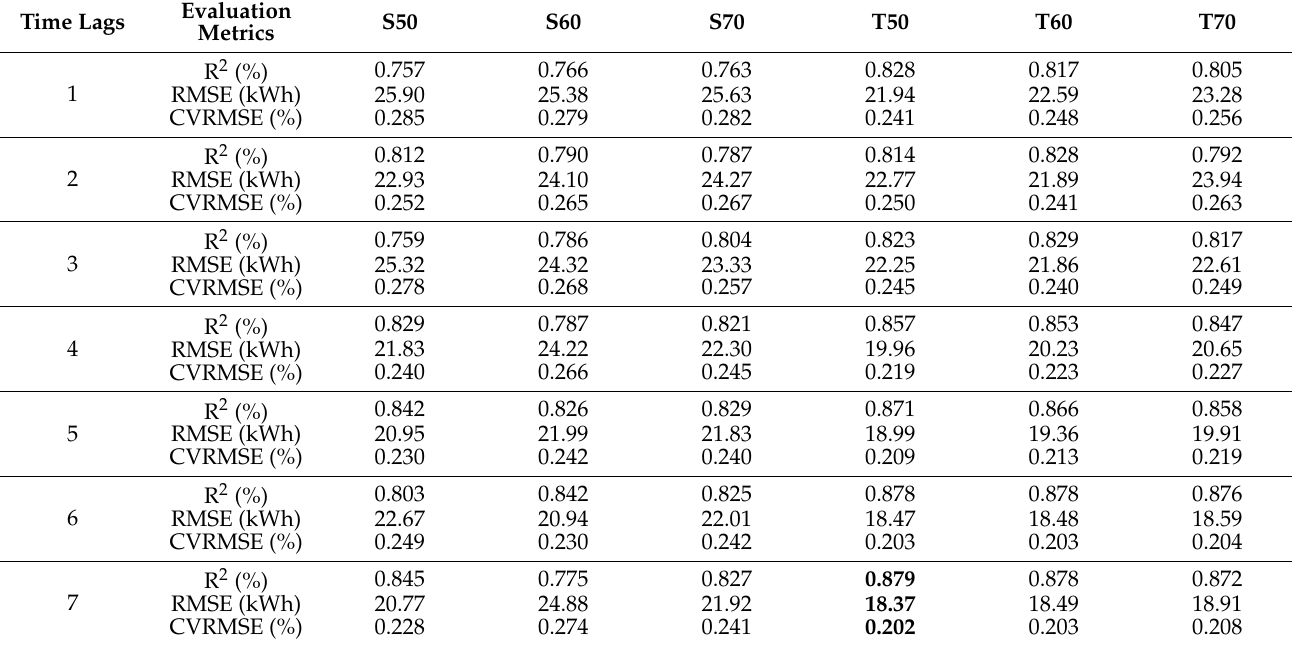
Table 7. Performance in the metrics evaluated when forecasting the energy consumption of the HVAC, using different time lags and HPs, applying the C4